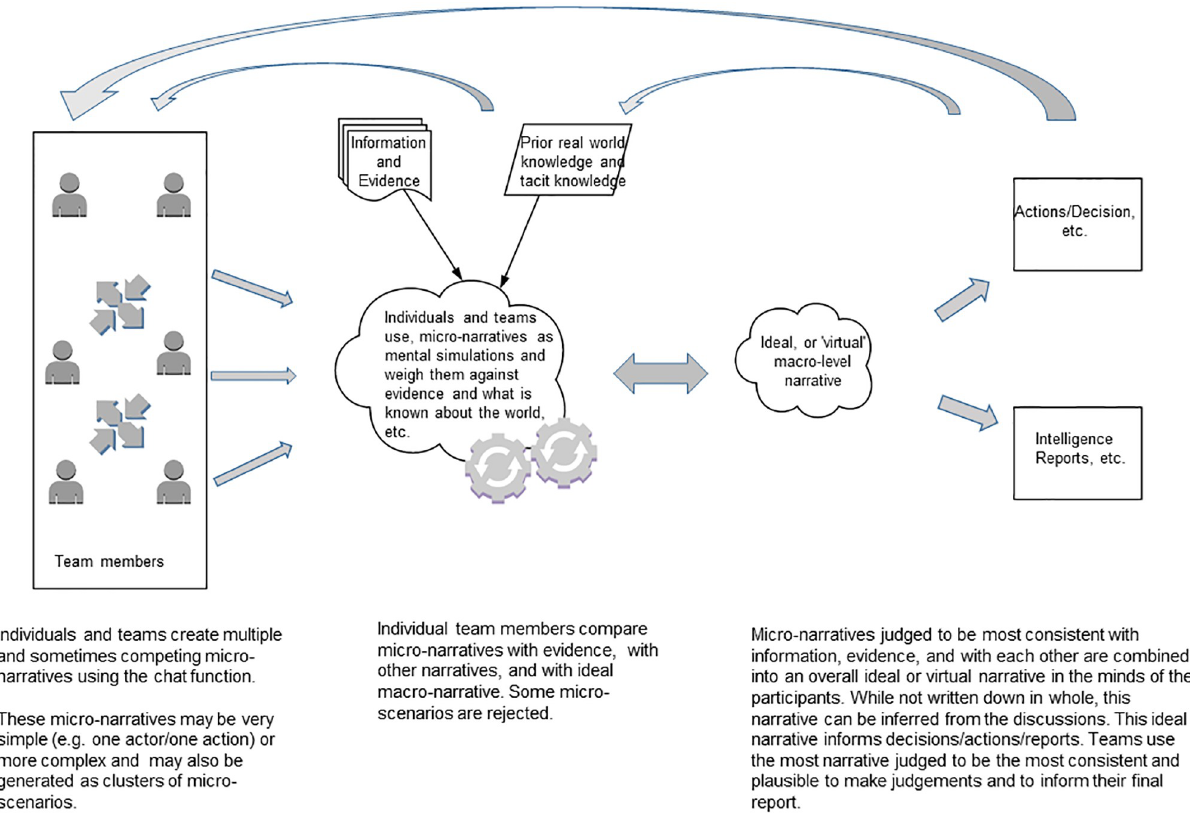
Fig 4. The process of micro-narrative generation and collaborative reasoning in producing judgements and the final intelligence report.